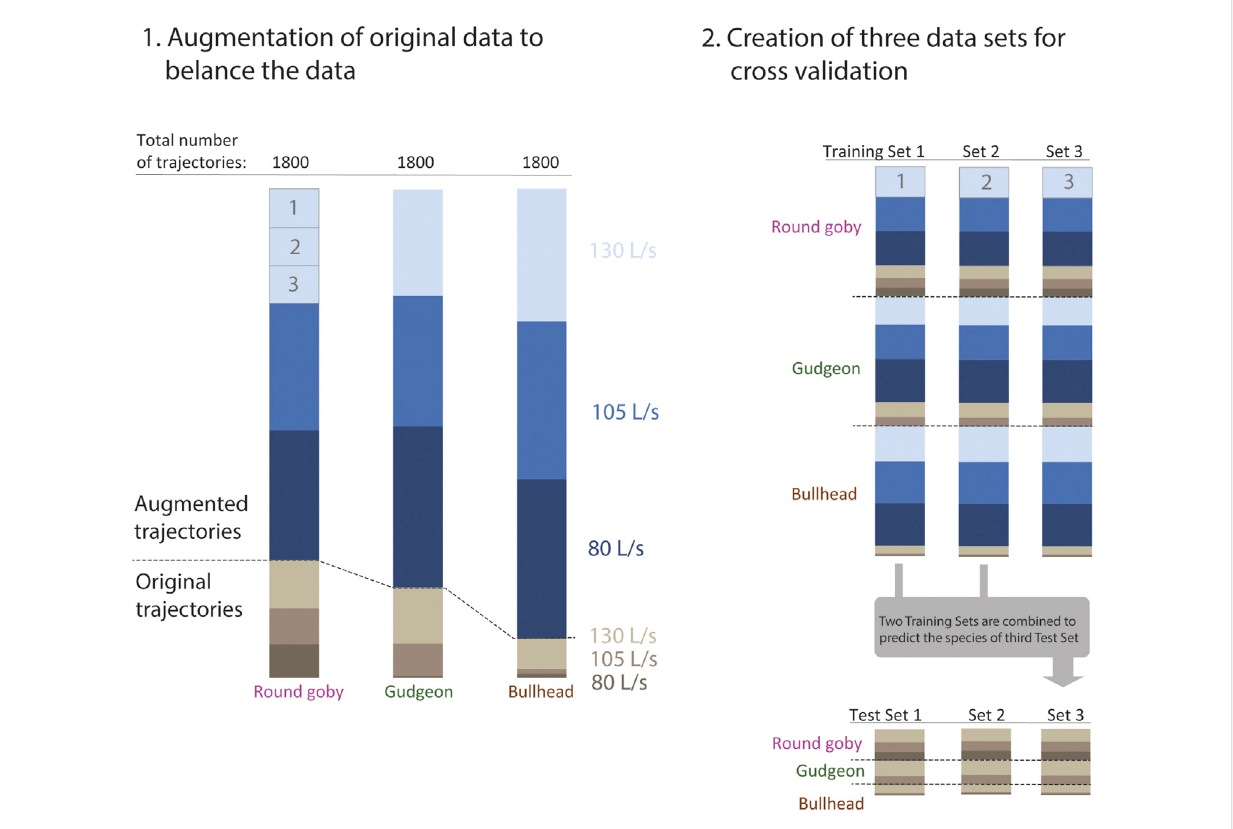
FIGURE 3 1.: The passage trajectories were used for training and validation of the convolutional neural network. The data were separated after categories ( fi sh species and water discharge). Data augmentation was applied to create three data sets for every species of same size (1800 trajectories). 2.: The species data sets were combined and split to create three balanced training data sets with equal proportion of augmented trajectories, species, and water dischargecategories.Inaddition,wecreatedthreetestsetsfromtheoriginaltrajectoriestovalidatethemodelsonlyonoriginaldata.Foreverycross validation, two training sets were combined and used for training the network. This network was then validated on the third test set, whose trajectories have not been seen by the model while